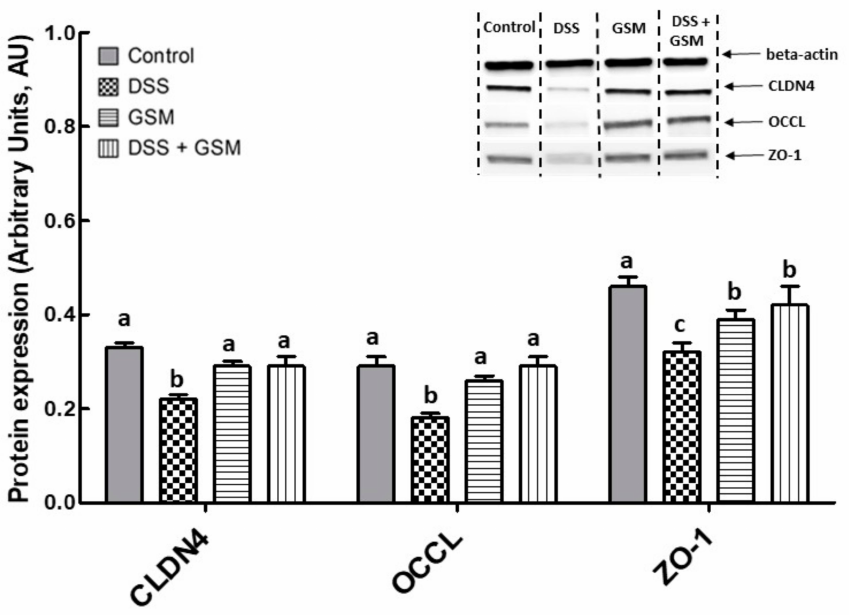
Figure 2. The effect of dietary treatments on tight junction protein expression in colon lysates. Unchallenged and DSS-treated pigs were assigned for 30 days to a control diet (Control and DSS groups) or 8% GSM diet (GSM and DSS + GSM groups). At the end of the experiment, colon samples from all animals ( n = 5/group) were collected and Claudin 4, occludin, and Zonula-1 expression levels were determined by using Western blot analysis. The tight junction protein expressions were normalized as ratio to β -actin band intensities. Results are expressed as arbitrary units (A.U.) and presented as means ± standard errors of the mean (SEM). Anova-one way followed by Fisher tests were used to analyze the effect of experimental treatments on protein expression. a,b,c Groups with unlike superscript letters were significantly different ( p <